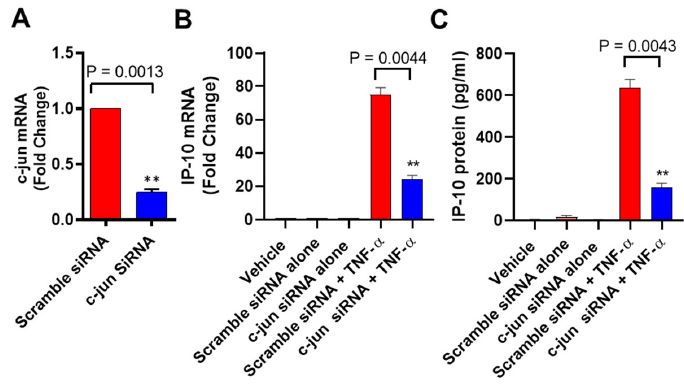
. Figure 4. TNF- α -induced IP-10 expression is attenuated in c-Jun-deficient cells. MCF-7 cells were transfected separately with c-Jun siRNA (20 nM) and scrambled siRNA (20 nM), as described in Materials and Methods. ( A ) After 36 h, real-time RT-PCR was performed to measure c-Jun expression. ( B , C ) MCF-7 cells transfected with c-Jun siRNA and scrambled siRNA were incubated with TNF- α for 24 h. Cells and supernatants were collected, and IP-10 mRNA and protein expression were determined by real-time RT-PCR and ELISA, respectively. All data are expressed as mean ± SEM ( n = 3). ** p <